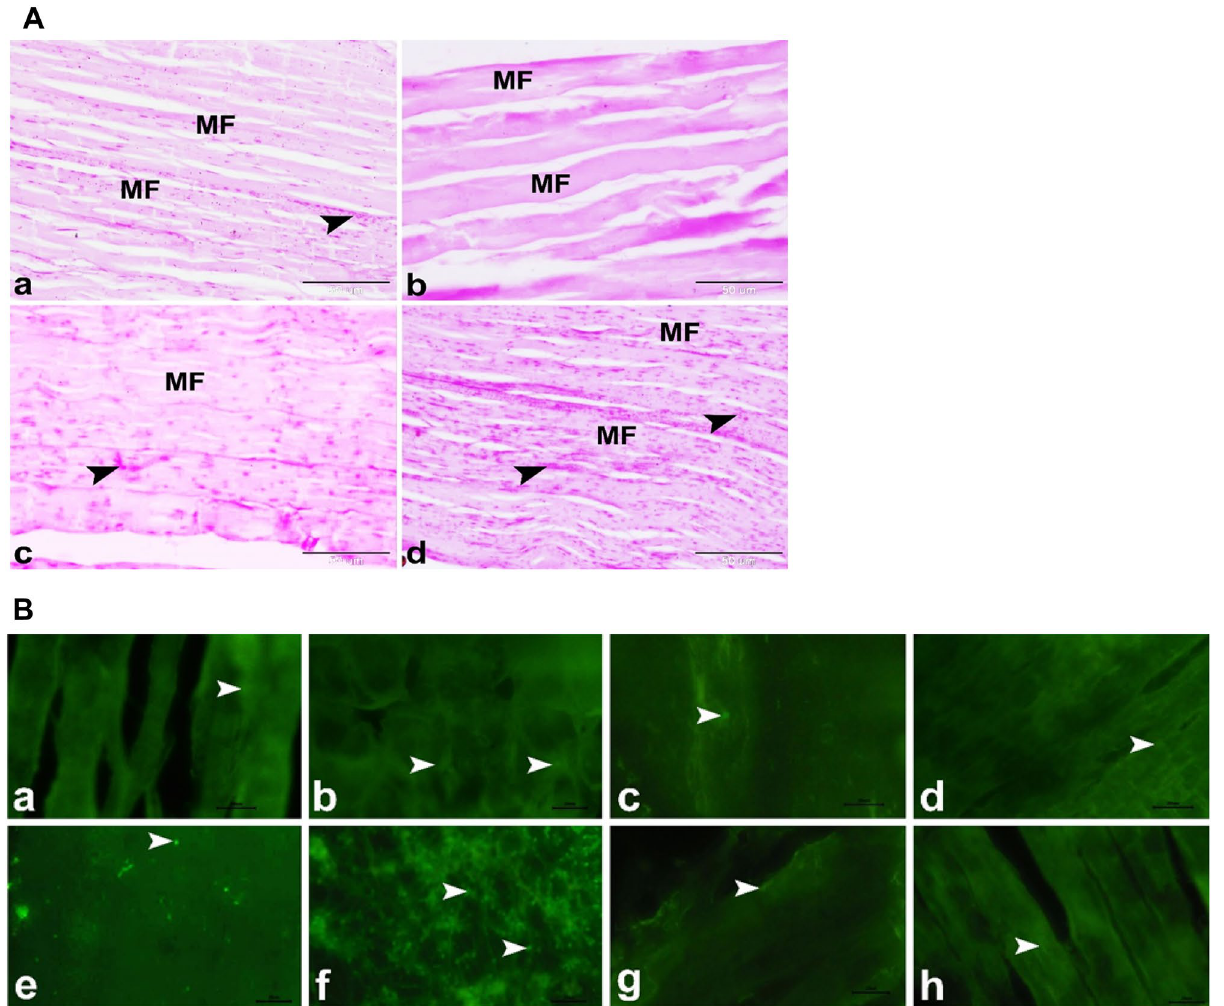
Figure 4. ( A ) Photomicrographs showing minimizing of the myotoxic side effects of SV by using microsponges formulas in rats. ( a ) Control group showing the normal architecture of the skeletal muscle in rat. The skeletal muscle was formed of several parallel elongated cylindrical muscle fibers (MF) with large amounts of PAS positive glycogen (arrowhead) in the sarcoplasm. ( b ) Free SV group showing the myotoxic side effects of SV as depletion of PAS positive glycogen (arrowhead) in the sarcoplasm of the wavy muscle fibers (FM). ( c ) FSV-6 group showing increased amounts of PAS positive glycogen (arrowhead) in the sarcoplasm of muscle fibers (FM). ( d ) FSV-1 group showing minimizing of the myotoxic side effects of SV. The skeletal muscle was formed of several parallel elongated cylindrical muscle fibers (MF) with large amounts of PAS positive glycogen (arrowhead) in the sarcoplasm. PAS, scale bar = 50 μm. ( B ) Photomicrograph of GR ( a–d ) and SOD2 ( e–h ) immunostaining in the skeletal muscles; ( a,e ) Control group, ( b,f ) Free SV group, ( c,g ) FSV-6 group and ( d,h ) FSV-1 group showing that GR immuno-expression (arrowheads) was nearly similar in all experimental groups, while SOD2 immuno-expression (arrowheads) was significantly increased in SV group and it was significantly decreased in FSV-6 group and FSV-1 group compared to control group, scale bar = 20